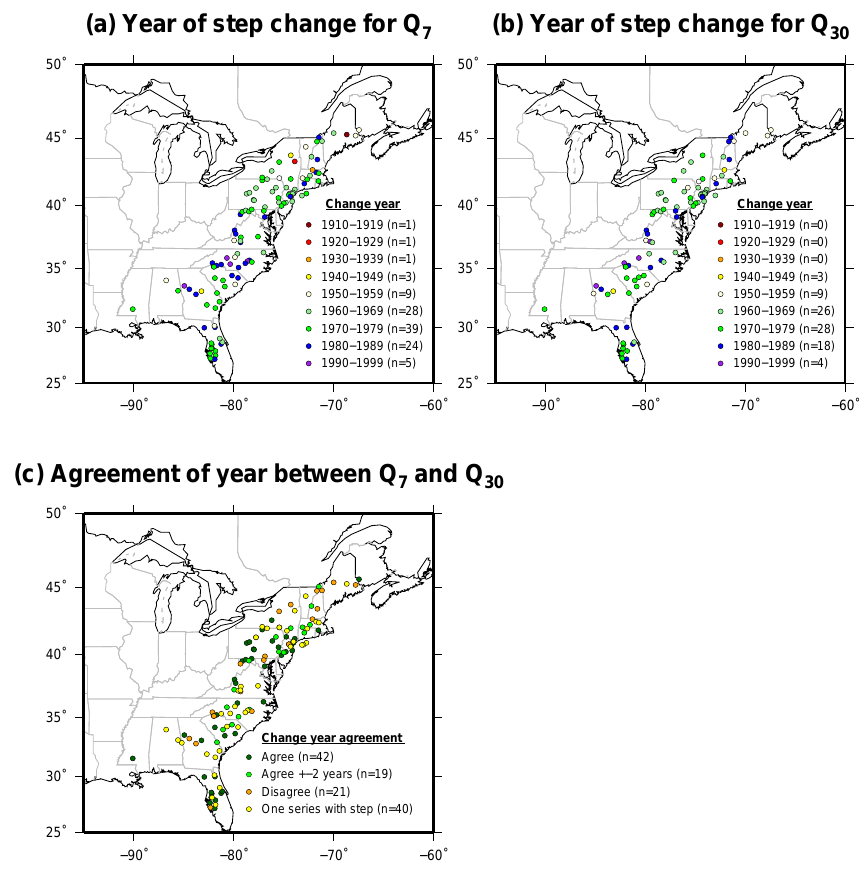
Figure 5. Year of step change for (a) Q7 and (b) Q30. (c) Agreement in year of step change between Q7 and Q30 time